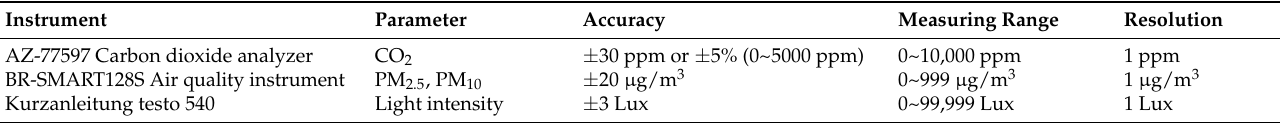
Table A1. Monitoring instrument parameters.